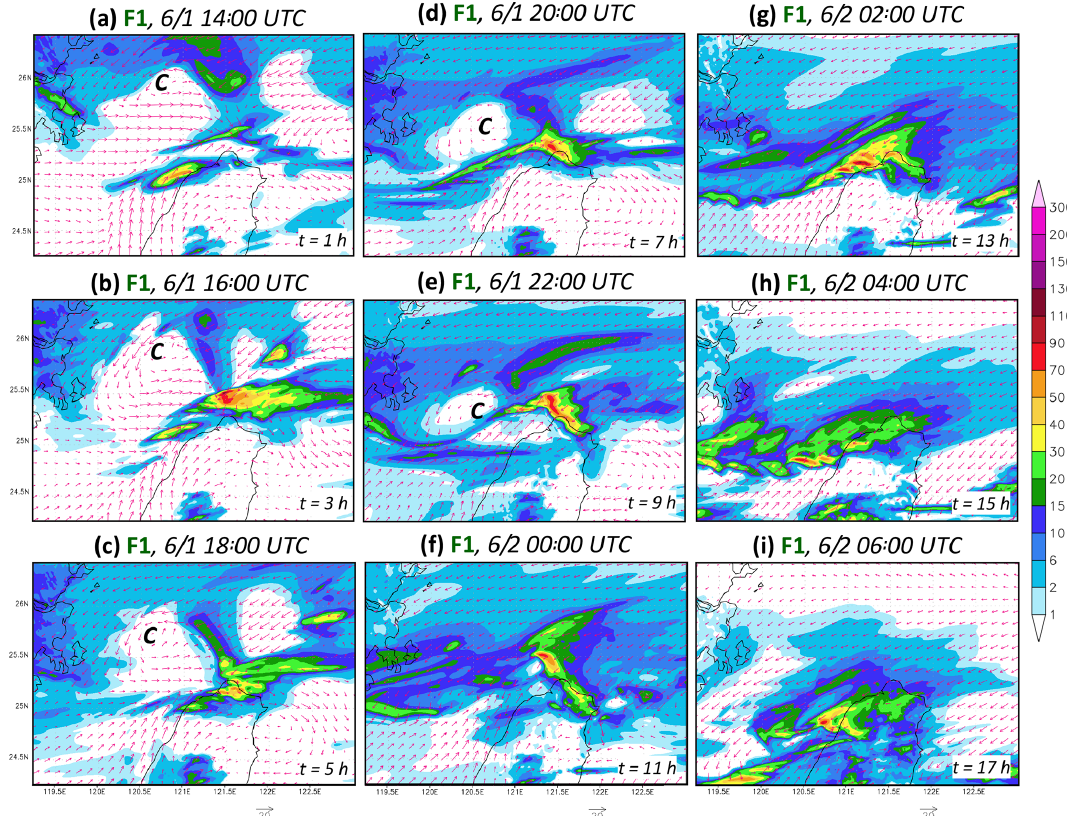
Figure 12. Model surface winds at 10m height (ms − 1 , reference vector at bottom) and hourly rainfall (mm, color) near northern Taiwan every 2h from (a) 06:00 to (i) 22:00UTC on 1 June 2017 in the F1 experiment.